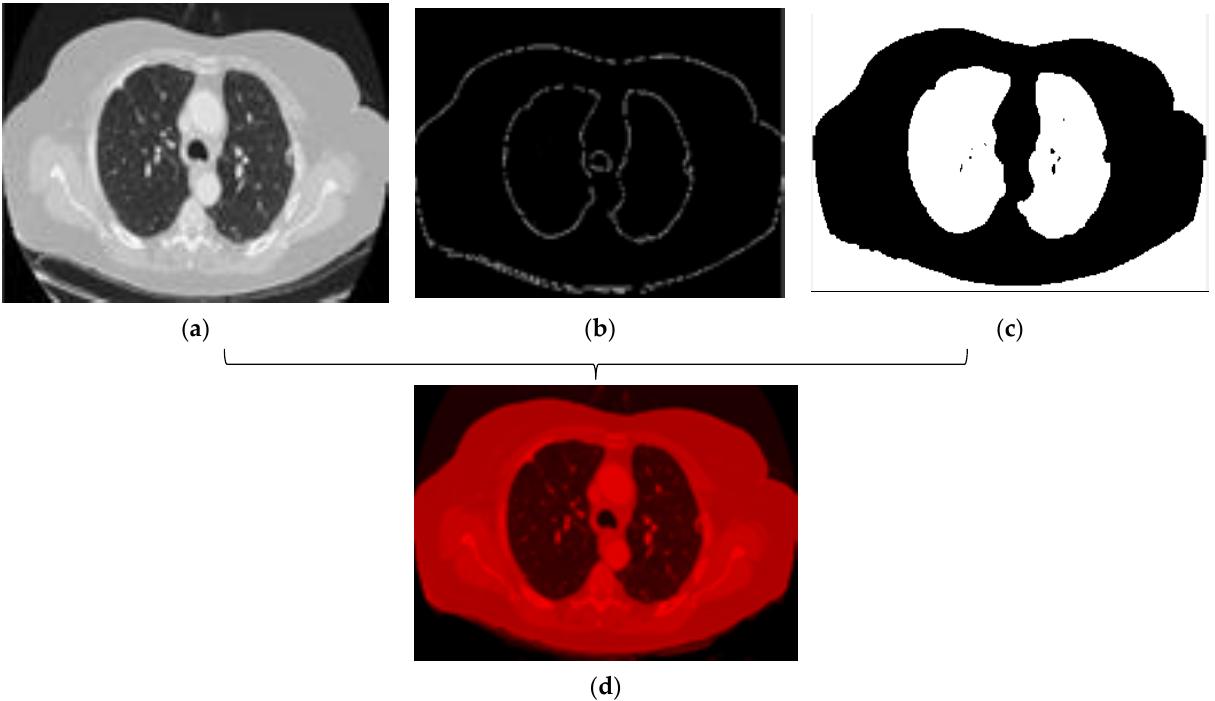
Figure 11. ( a ) . First new channel, ( b ) . Second new channel, ( c ) . The second new channel ( d ) . Result of a combination of Figure 11. ( a ). First new channel, ( b ). Second new channel, ( c ). The second new channel ( d ). Result of a combination of new new channels.